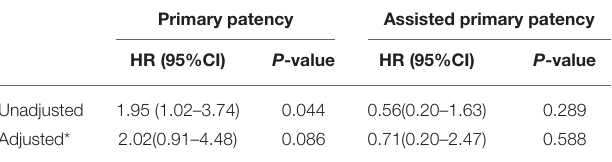
TABLE 3 | Comparison of primary patency and assisted primary patency between the patients with and without history of previous CVC placement in Cox regression model.